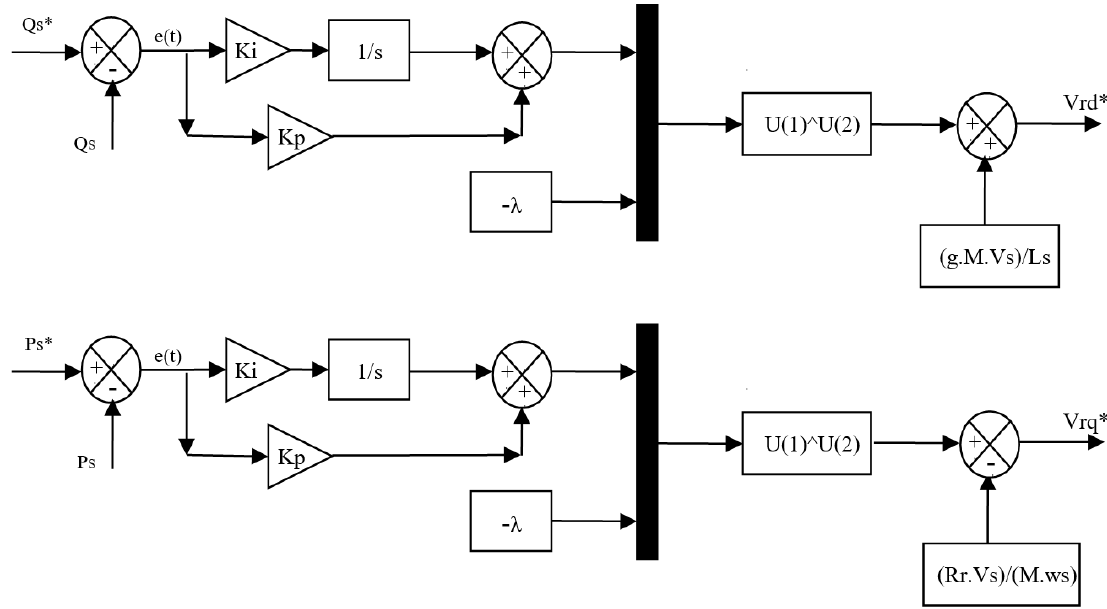
Figure 14. The internal structure of the proposed DVC method.